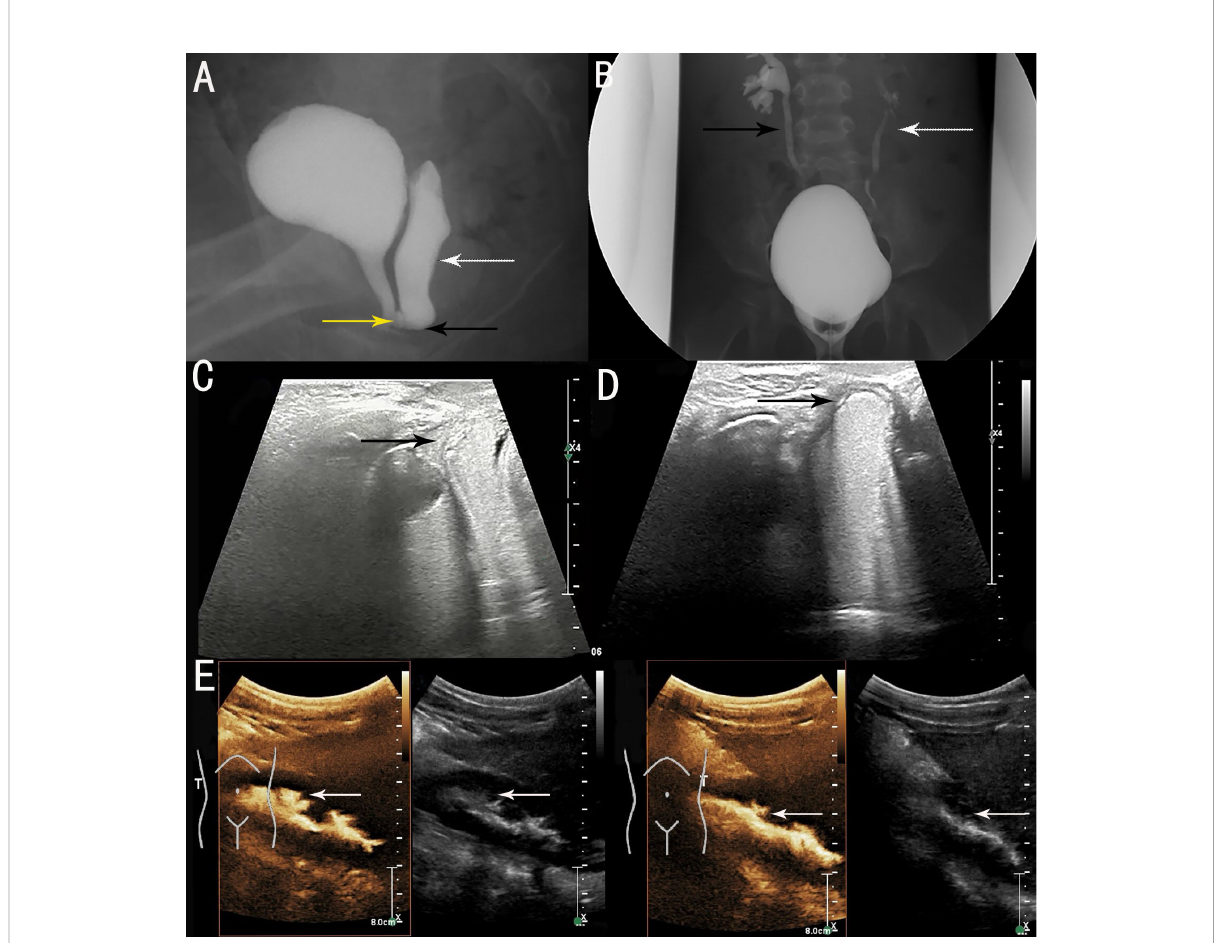
FIGURE 1 Preoperative imaging examinations. (A) voiding cystourethrography (VCUG) showed vaginal obstruction (black arrow), vaginal effusion (white arrow) and urethra-vaginal fi stula (yellow arrow). (B) VCUG showed bilateral VUR (grade III on right side [black arrow] and grade II on left side [white arrow]). (C) contrast-enhanced voiding urosonography (ceVUS) revealed urethra-vaginal fi stula (black arrow). (D) ceVUS revealed vaginal obstruction with vaginal effusion (black arrow). (E) ceVUS revealed bilateral VUR (grade III on right side and grade II on left side) (white